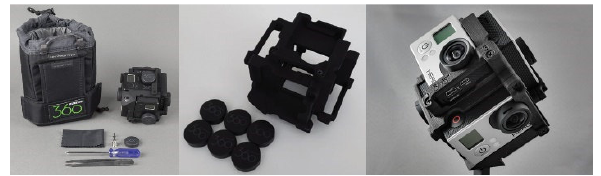
Figure 1. The Freedom 360 system.